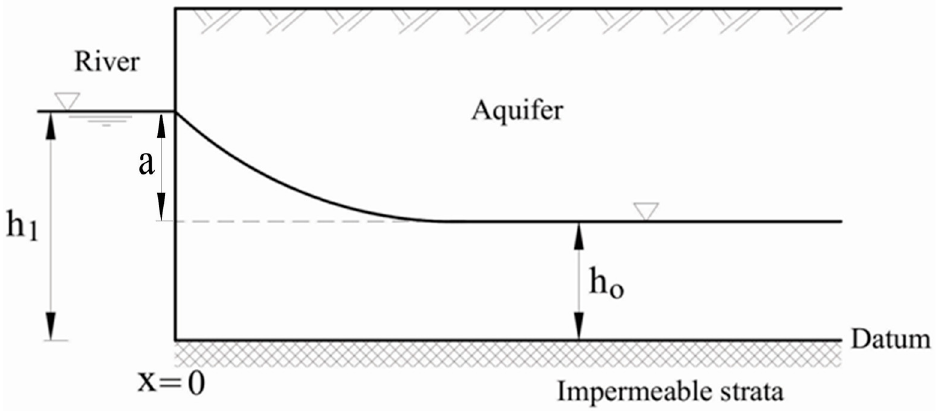
Figure 1. Unsteady, one-dimensional flow in a semi-infinite unconfined aquifer.